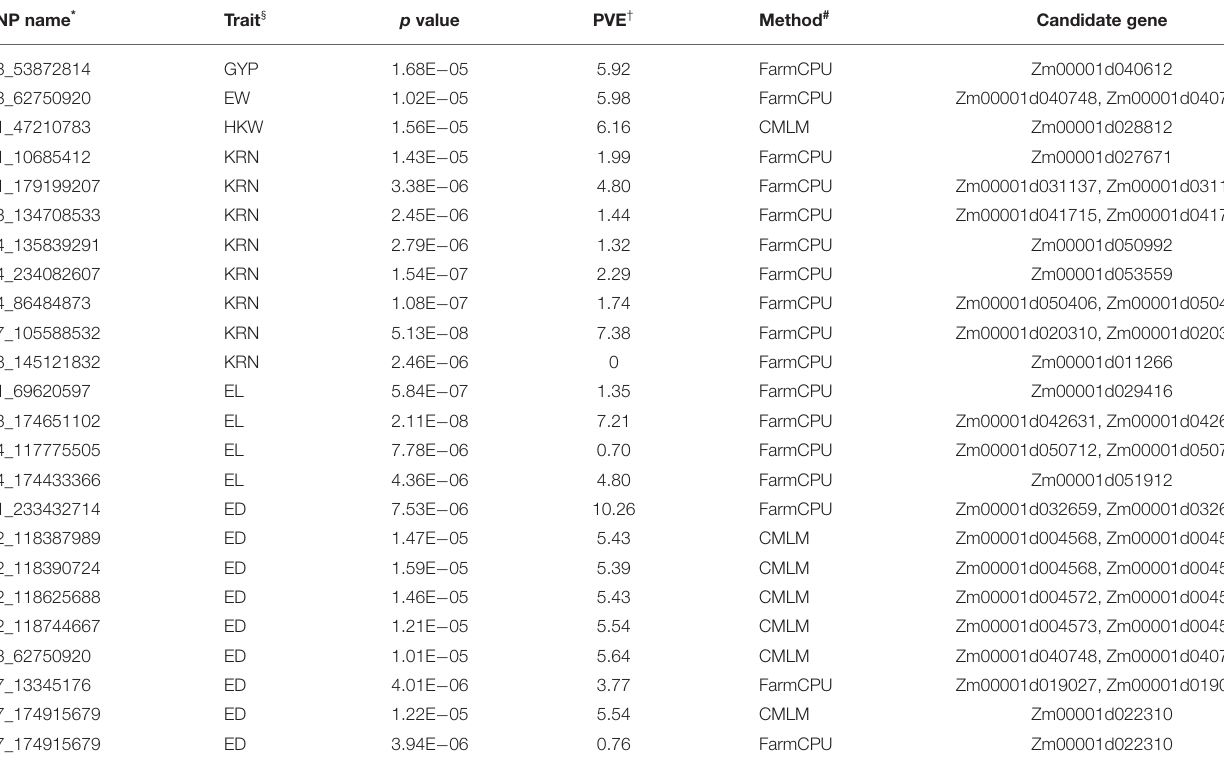
TABLE 1 | Significant SNPs and candidate genes for grain yield and yield-related traits using two GWAS